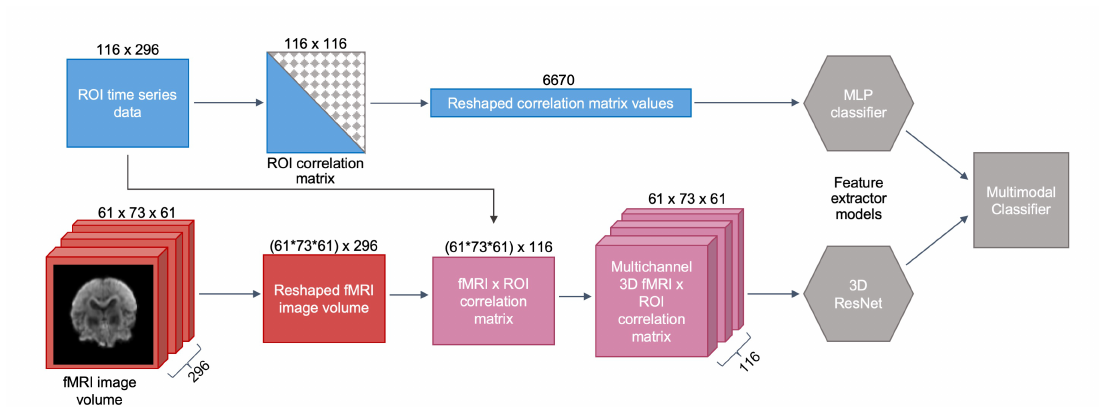
Figure 1. Preprocessing workflow. Construction of correlation matrices, or activation maps (terms are used interchangeably) between fMRI voxels × ROI time series and between pairs of ROI time series alone. Numbers on edges of the objects indicate matrix dimensions at the current step, e.g., the dimensions of the fMRI scan and ROI time series data are ( H = 61, W = 73, D = 61, T = 296 ) and ( N = 116, T = 296 ) , respectively. For more detail on ResNet and MLP network architectures, refer to Figure